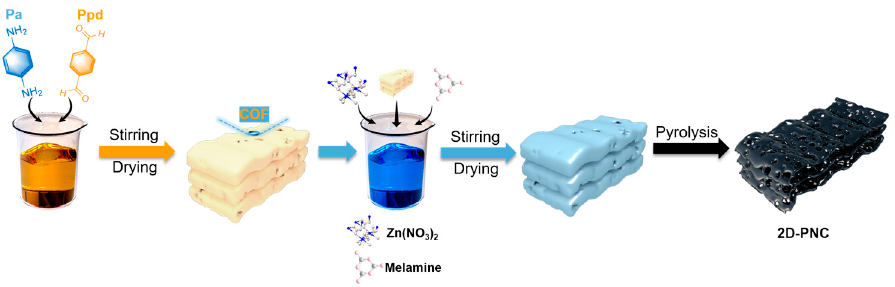
Figure 1. Schematic illustration of the synthesis of 2D-PNC.